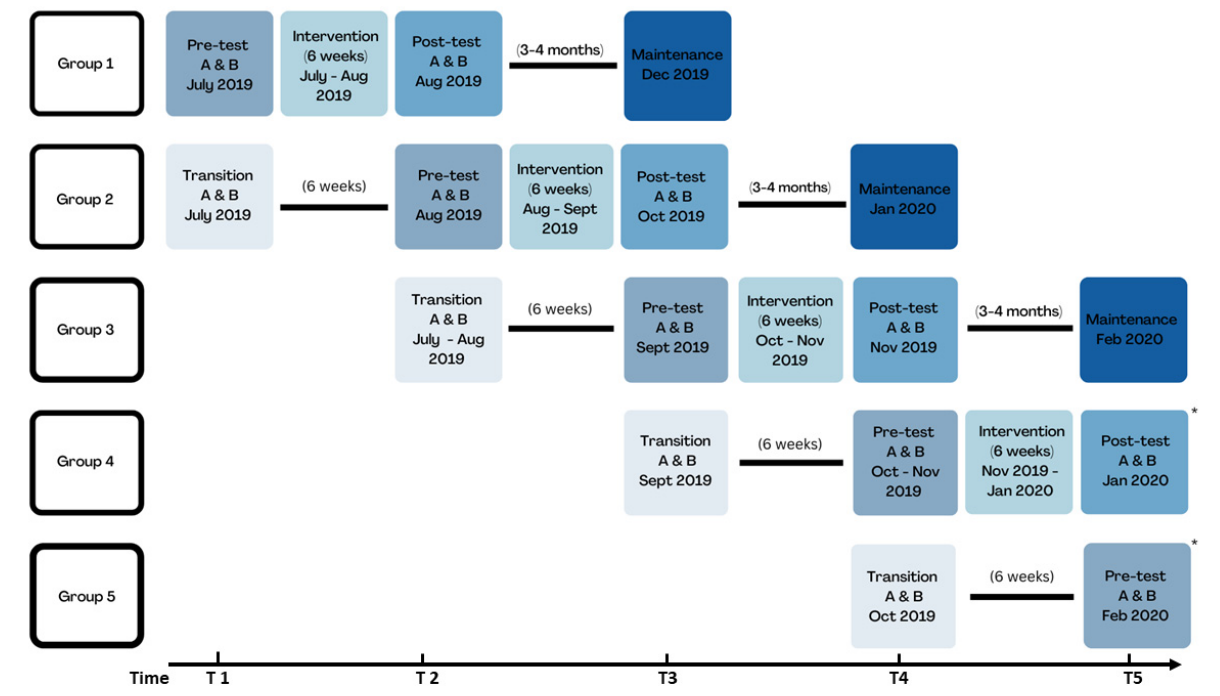
Figure 1. Modified stepped-wedge study design for HEPP program. This figure shows the modified stepped-wedge study design with data collection time points T1 through T5. The transition measure was critical for the delayed intervention (or wait listed control) group. Due to the COVID-19 pandemic in early 2020, group 4 did not complete a maintenance measure (last measure was post-test). Group 5 did not complete the program and had no post-test or maintenance measure (last measure was pre-test).